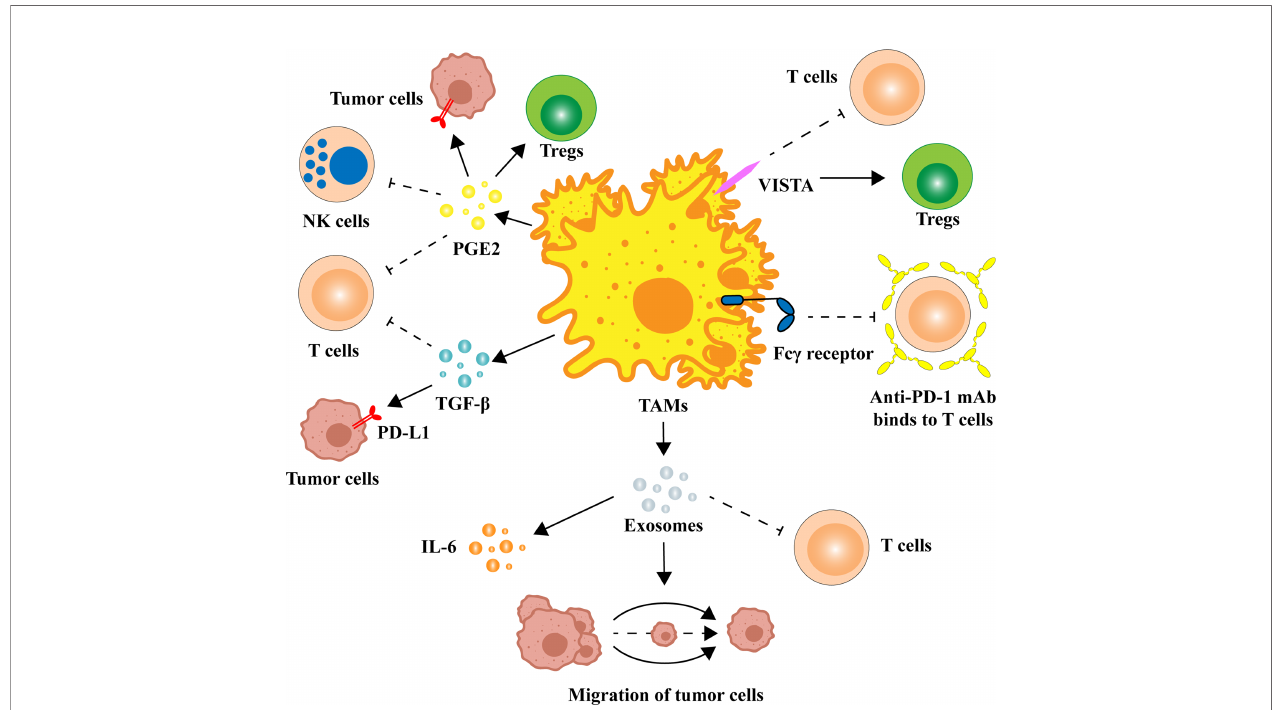
FIGURE 1 | Multiple ways in which TAMs regulate the expression and function of PD-1/PD-L1. TAMs can release a variety of cytokines to alter the TME, such as TGF- b and PGE2. There are also homologous immune checkpoint ligands on the surface of TAMs that can block anti-PD-1/PD-L1 immune ef fi cacy. M2 TAM- derived exosomes are also potentially associated with PD-1/PD-L1 inhibitors. IL, interleukin; mAb, monoclonal antibody; NK cell, natural killer cell; PD-1, programmed cell death 1; PD-L1, programmed cell death ligand-1; PGE2, prostaglandin E2; TAM, tumor-associated macrophage; TGF- b , transforming growth factor- b ; Treg, regulatory T cell; VISTA, V-domain Ig-containing suppressor of T-cell